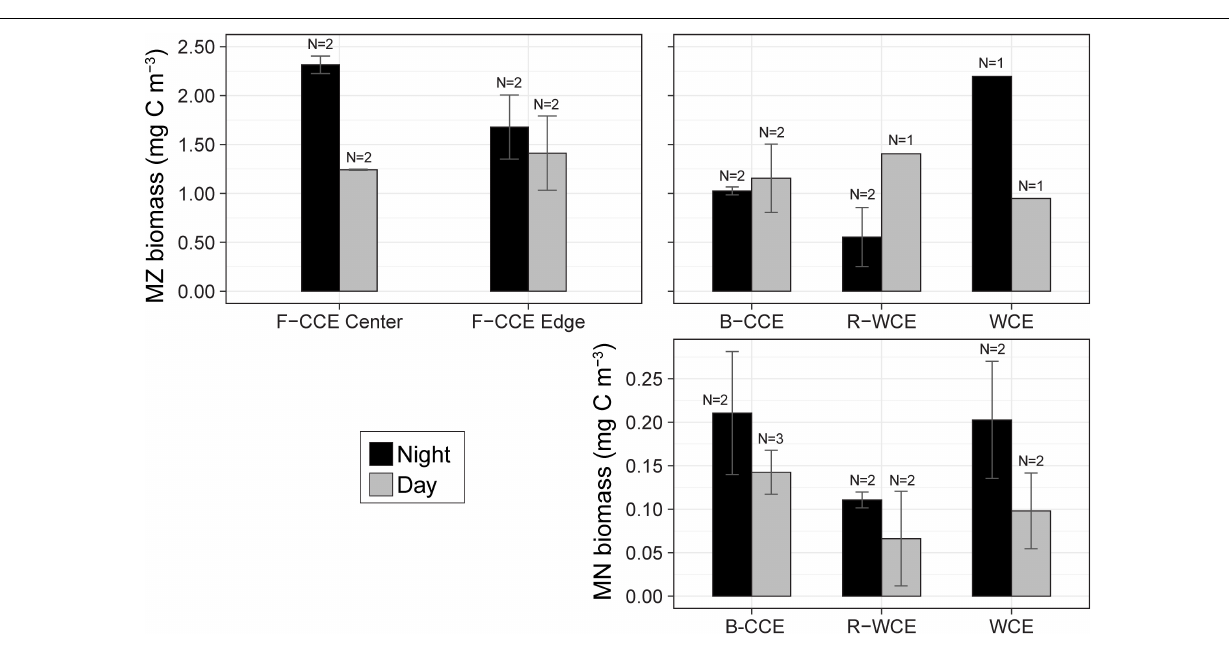
mesozooplankton biomass in the top 100 m at night was at least three times greater in the WCE (134 mg C m − 3 ) than in the B-CCE (44 ± 3 mg C m − 3 ) and the R-WCE (38 mg C m − 3 ) ( Figure 5 ). During the day, biomass in the top 100 m decreased in the B-CCE (35 ± 6 mg C m − 3 ) and the WCE (27 mg C m − 3 ), while biomass in the R-WCE increased (62 mg C m − 3 ). Biomass was generally higher in all other depth strata during the night except for the WCE 400–300 m depth stratum ( Figure 5 ).